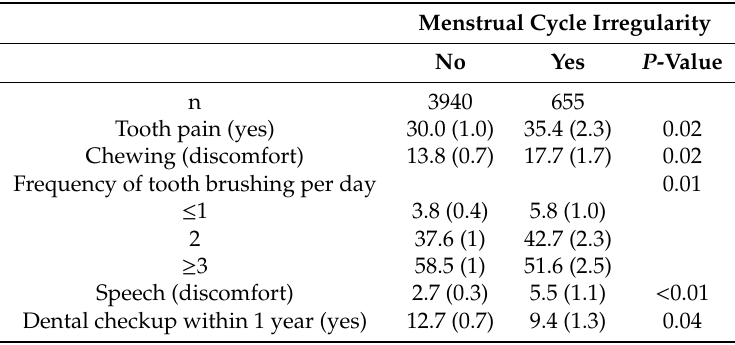
Table 2. The e ff ects of oral health on menstrual cycle irregularity. Table 2. The effects of oral health on menstrual cycle irregularity.